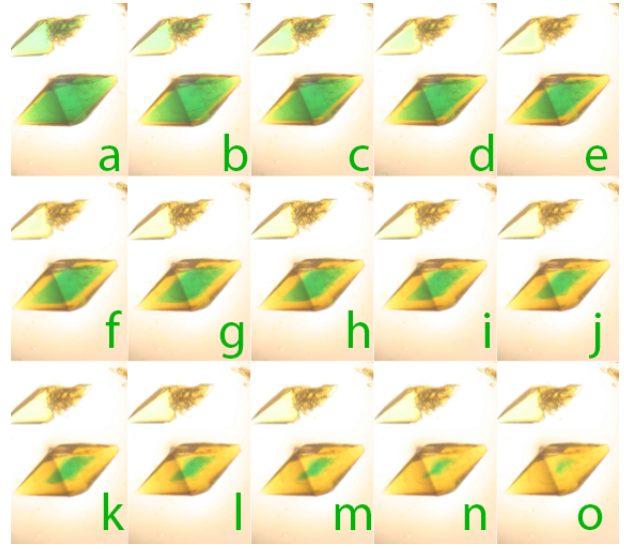
Figure 3. Tetragonal crystals of thaumatin, the larger about 1 mm in length, were stained to saturation over 48 h with the pH sensitive dye bromothymol blue. The crystal was initially at pH 8.25. The mother liquor was then removed and replaced with equivalent mother liquor but at pH 6.5. As H 3 O + ions diffused into the crystal, the incorporated bromothymol blue dye transformed chemically and yielded a yellow color. The change of color again shows a clear leading edge. The total time required for complete color transformation was about 35 min. The series of images ( a – o ), taken at appropriate time intervals, shows the progress of the